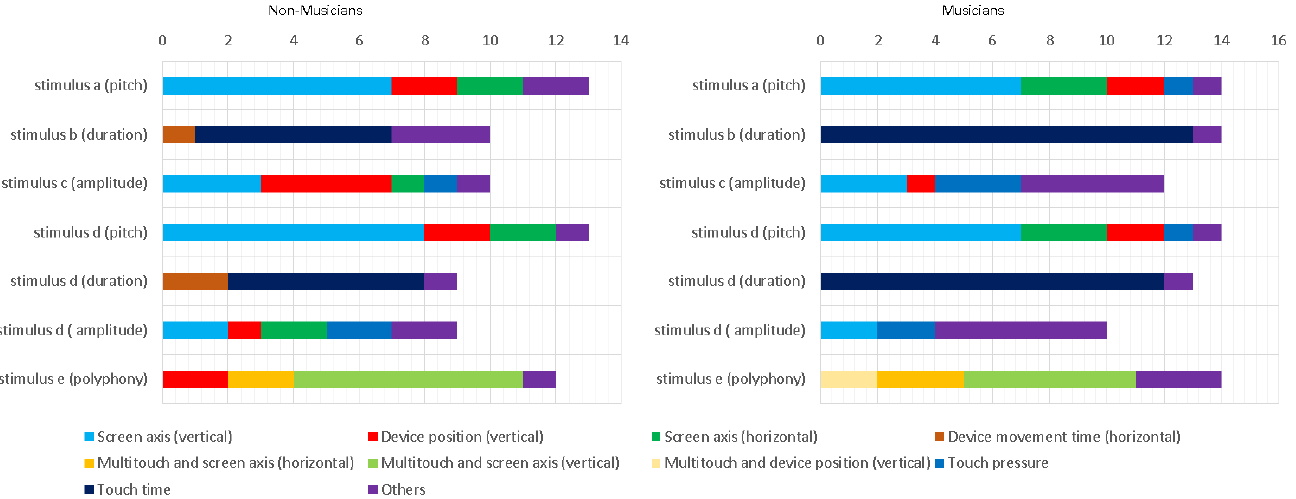
Figure 5. Frequencies of gestures performed by participants for each stimulus in phase 1. Left : Non-musician participant frequencies; Right : Musician participant frequencies; Full results reference: Tables A3–A9.